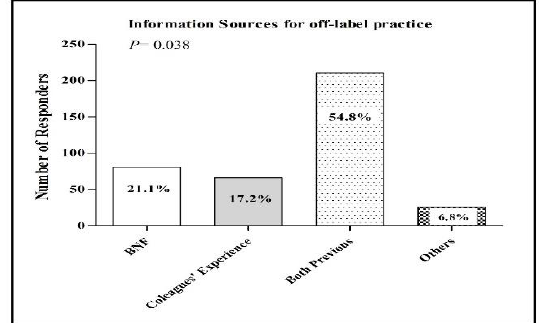
Figure 3. The information sources for the off- label prescribing practice. n =383 total number;